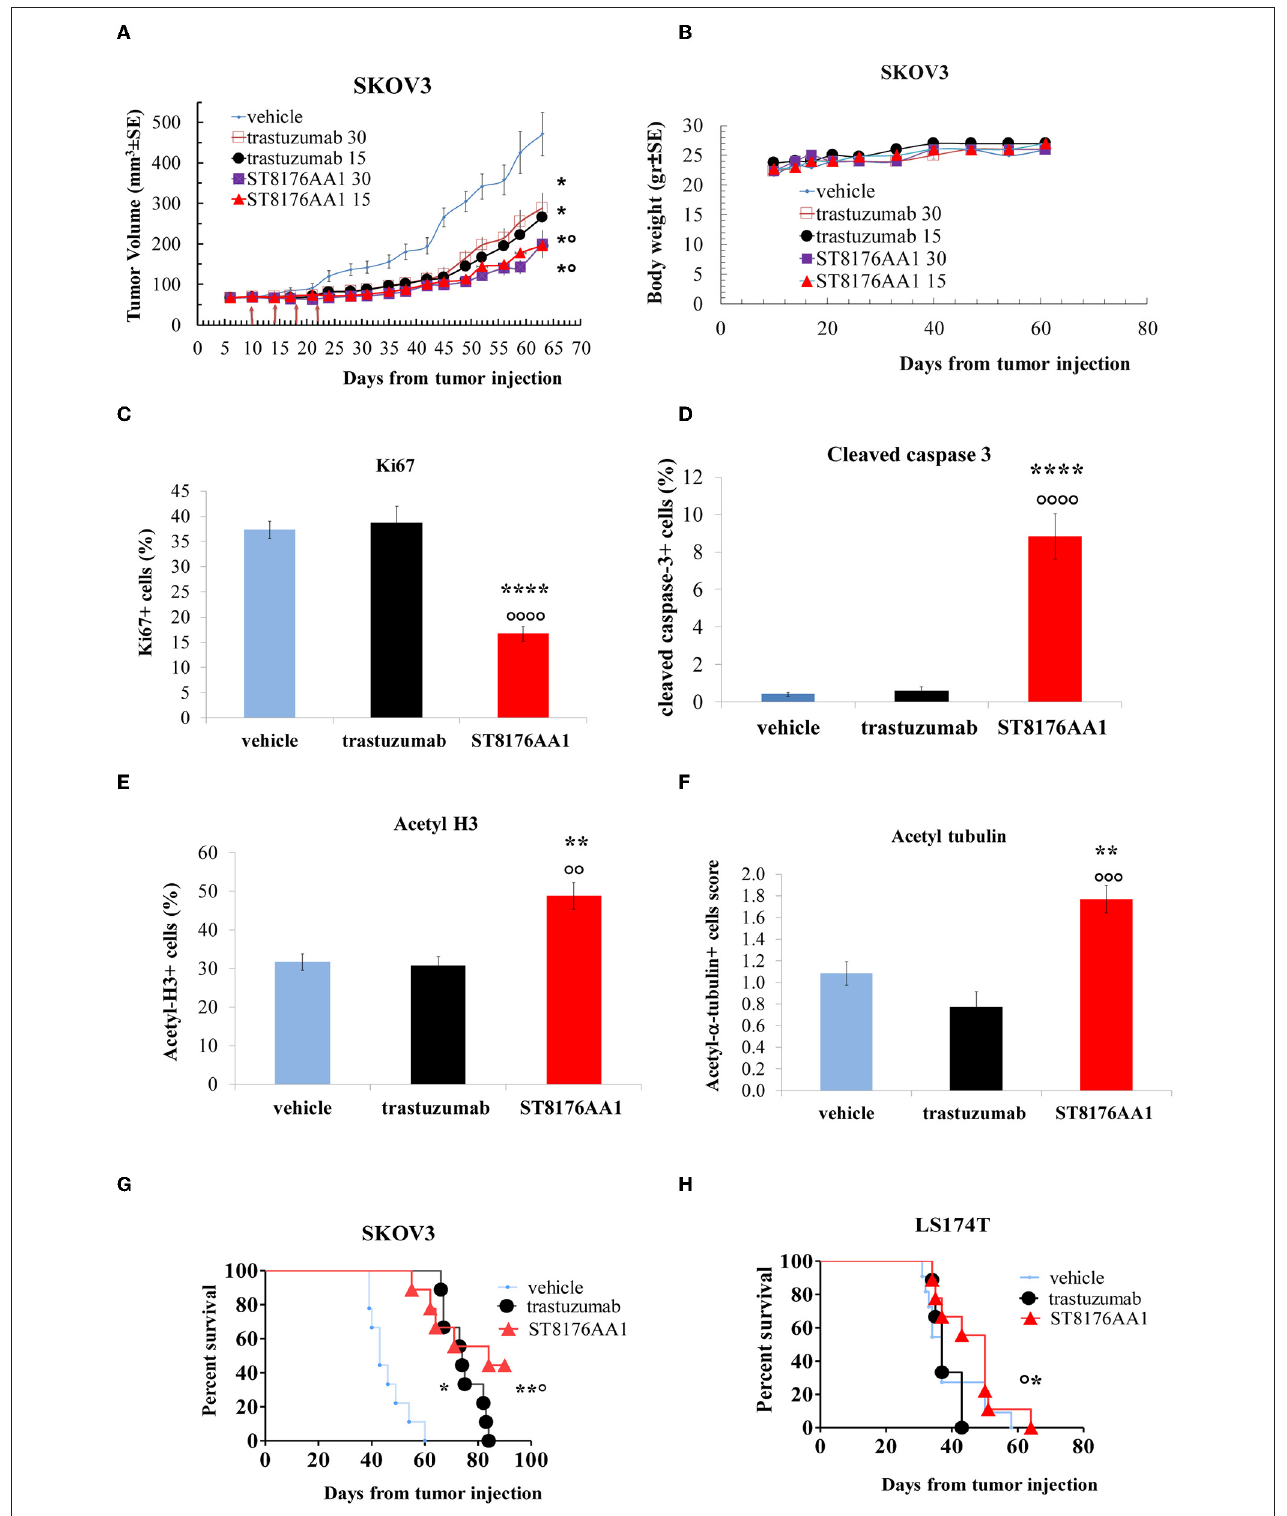
FIGURE 8 | Anti-tumor efficacy of ST8176AA1 in tumor xenografts. (A) Subcutaneous tumors were induced in nude mice (10/group) by injecting human SKOV3 cells ovary carcinoma. When tumor masses reached an average size of 50 mm 3 mice were treated i.p. (4 doses of 15 or 30 mg/kg once every 4 days, starting 10 days after tumor cell transplantation) with ST8176AA1 or trastuzumab. One group received vehicle (PBS) with the same schedule. Tumor growth was monitored using a